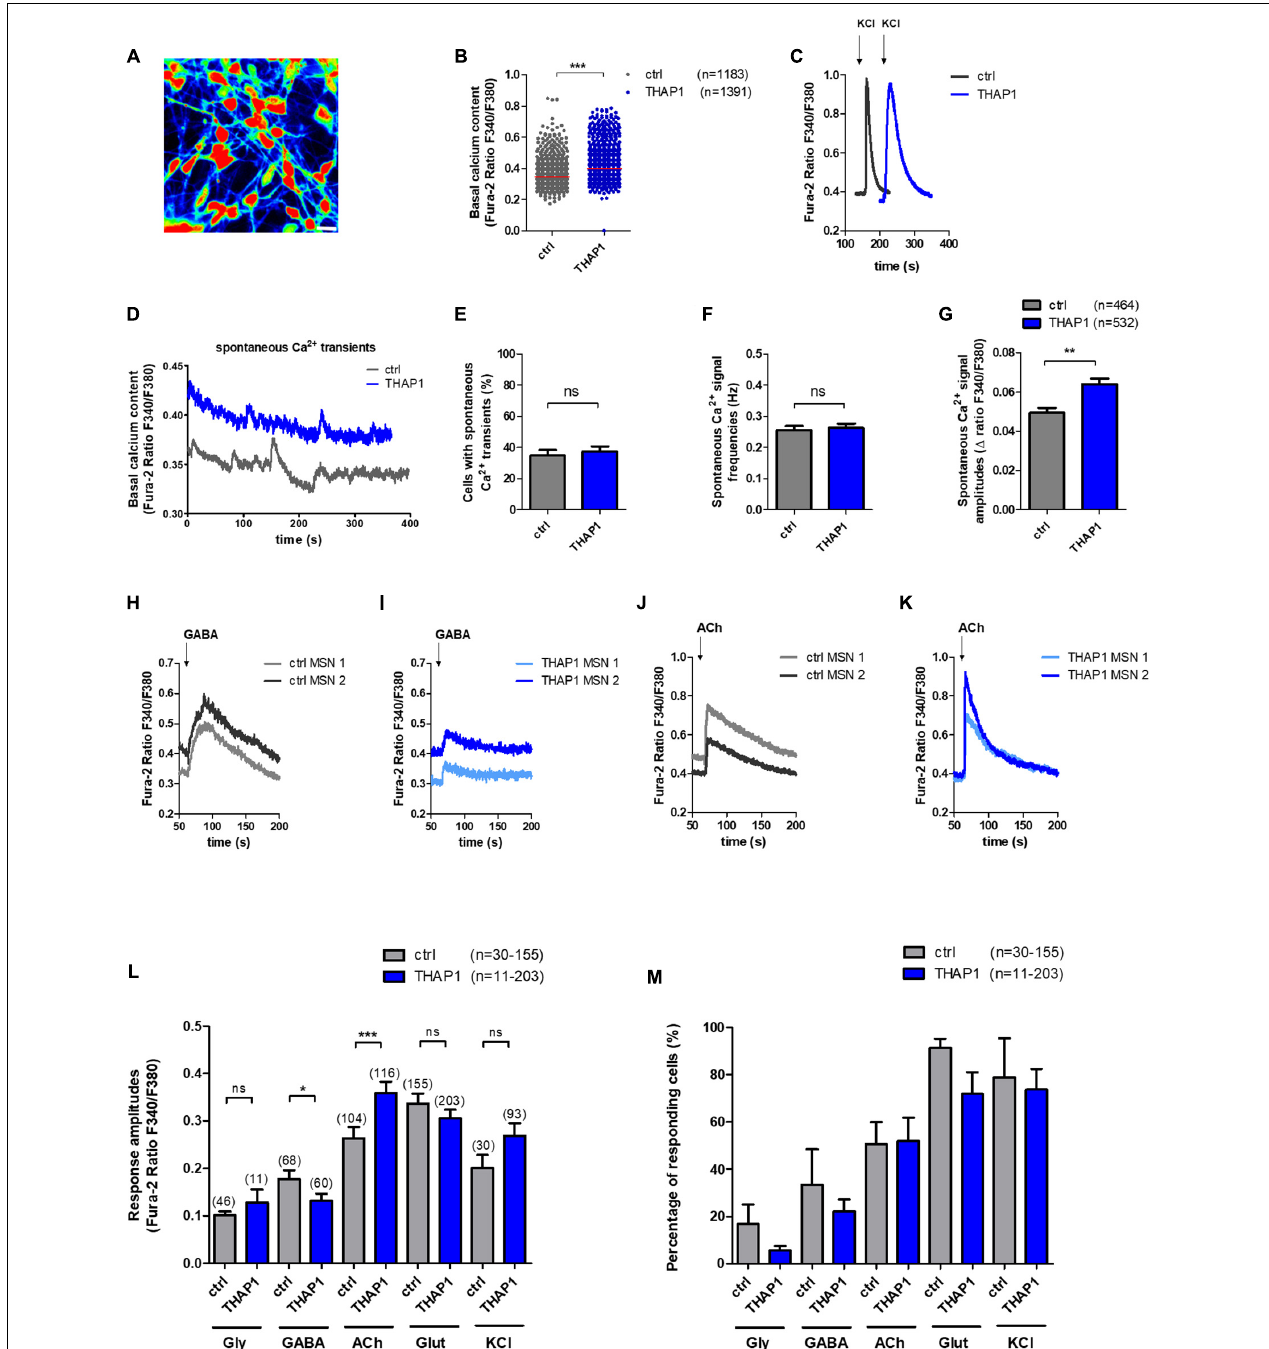
FIGURE 3 | Spontaneous intracellular calcium (Ca 2 + ) dynamics and neurotransmitter-induced Ca 2 + signaling of MSNs derived from DYT-THAP1 patients and healthy controls. Intracellular Ca 2 + transients are presented as ratios of the fluorescence signals obtained at 340 and 380 nm (F 340 /F 380 ). (A) Representative image of Ca 2 + recording of THAP1 MSNs loaded with Fura-2. Scale bar indicates 30 µ m. (B) Basal intracellular Ca 2 + levels were significantly elevated in THAP1 ( n = 1,391) compared with control MSNs ( n = 1,183, *** p < 0.001, non-parametric Mann-Whitney test). (C) Representative traces of intracellular Ca 2 + changes of control and THAP MSNs induced by application of KCl (50 mM) to monitor the viability and excitability of MSNs. (D) Representative traces of spontaneous Ca 2 + peaks of control and THAP MSNs. (E) The percentage of cells showing spontaneous Ca 2 + transients were not significantly different between both MSN groups ( ∼ 35%, control n = 464, THAP1 n = 532, unpaired t -test). (F) Spontaneous Ca 2 + signal frequencies of MSNs were not significantly different between MSNs of both groups ( ∼ 0.26 Hz, control n = 464, THAP1 n = 532, non-parametric Mann-Whitney test). (G) Spontaneous Ca 2 + amplitudes of MSNs were significantly elevated